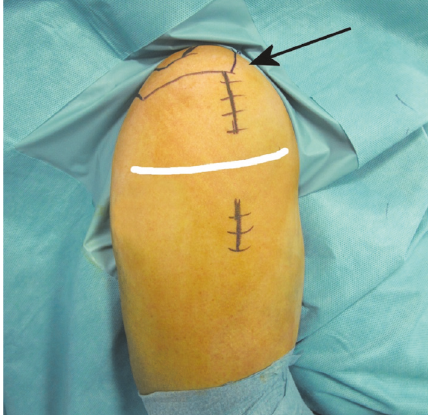
Figure 1: Surgical field of a right shoulder showing the two skin incisions performed for the MIPO technique. The proximal incision starts at the anterolateral corner of the acromion (arrow) and is approximately 5cm long; the length of the distal incision varies according to the number of diaphyseal screws implanted. The white line shows the level and course of the axillary nerve.